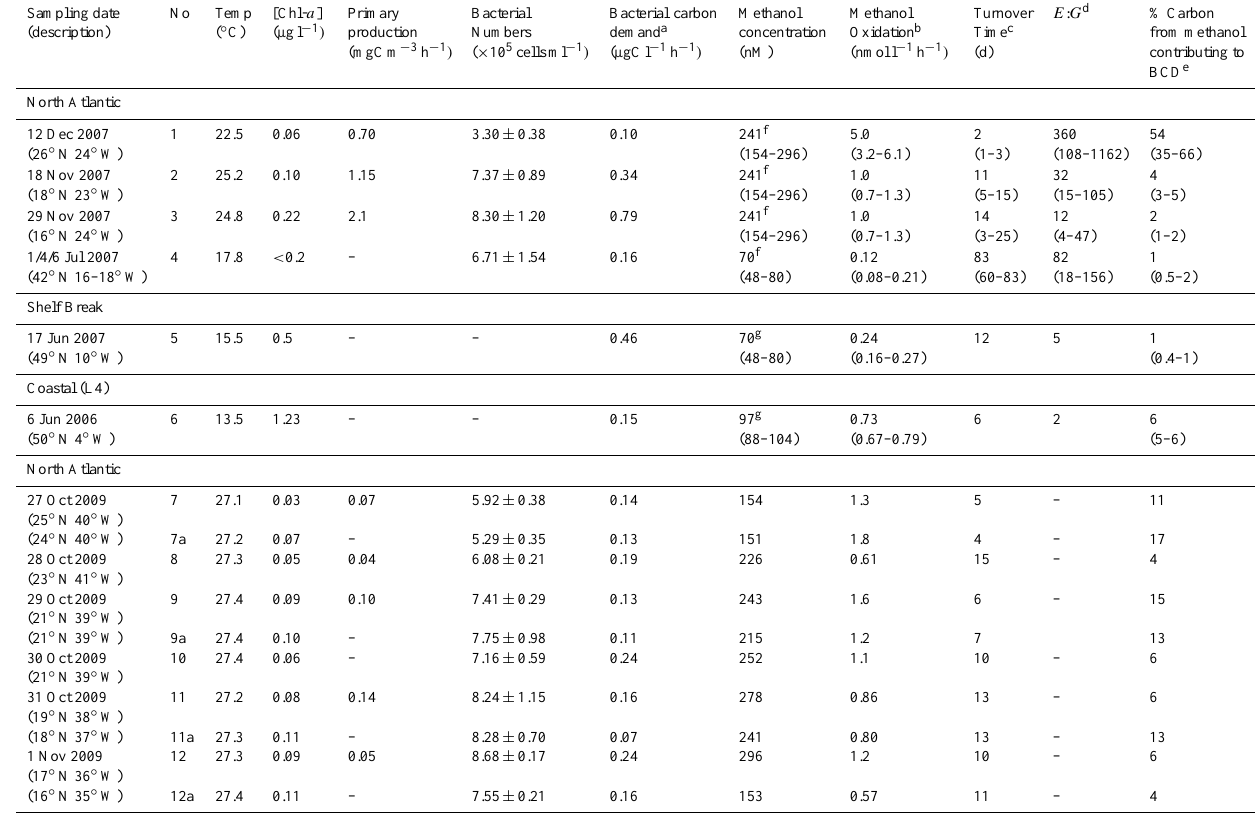
a From Table 1. b Methanol oxidation to CO 2 . Data in brackets show the minimum and maximum oxidation rates over a diel cycle and/or over the range in methanol concentrations used. c Turnover times estimated from radiochemical experiments ( k − 1 ) . d Methanol uptake into particles ( G ) was not determined for stations 7–12a. Values in brackets shows the minimum and maximum ratio determined over diel cycles sampling hourly, except for station 4 which shows variability over 3 days. e For diel stations 1–3, methanol carbon contributing to BCD is calculated for every hour using the average methanol oxidation rates (using a methanol concentration of 241nM and in situ k ) divided by the BCD. The average methanol contribution to BCD over the diel experiment in then calculated. Values in brackets use the minimum and maximum methanol oxidation rates. For stations 4–12a, minimum and maximum contributions are calculated from the range in methanol oxidation rates found. f Methanol concentrations were not determined. Values for stations 1–3 and 4–5 are based on the average surface concentrations measured between 16–25 ◦ N and 42–49 ◦ N respectively, during October/November 2009 transect of the Atlantic Ocean (AMT19, n = 6 for both average values). g The concentration for station 6 is based on the average concentration determined at this station (L4) during May/June 2010 ( n = 4 ). Data in brackets show the minimum and maximum